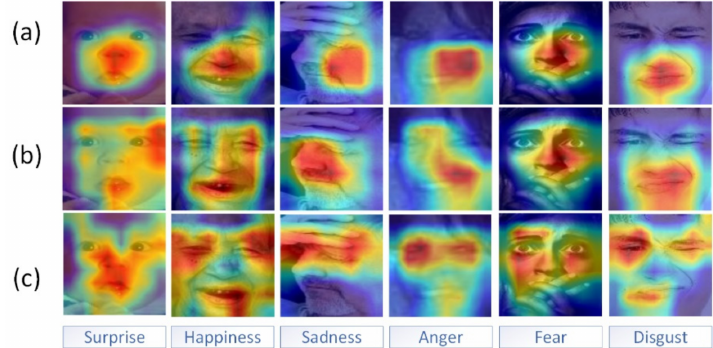
Figure 4. Visual comparison of gradient class activation mapping of RAF–DB (the three methods include the presence or absence of pyramids and single or cascading attention). From top to bottom, the visualization results are shown for the methods ( a ) without a pyramid but with cascading attention, ( b ) with a pyramid but with a single attention block, and ( c ) with a pyramid and cascading attention are shown in the expression images. The expression images from top to bottom show the visualization results for the methods without the pyramid but with cascading attention, with pyramid but with a single attention block, and with pyramid and cascading attention. Copyright